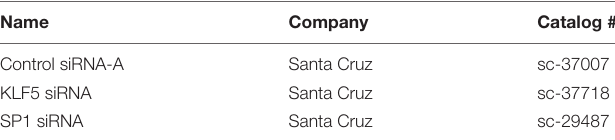
proliferation of normoxic as well as hypoxic ECs (31–34). TABLE 1 | siRNAs for